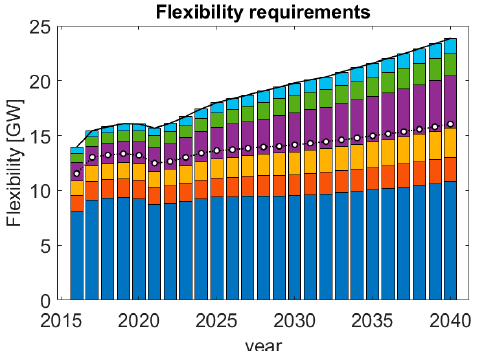
Figure 16. Current and future flexibility requirements related to MSD balancing under the TSO’s demand/VRE capacity growth scenario. Colors in the plot indicate the different Italian regions: dark blue is NORD, red is CNORD, yellow is CSUD, Purple is SUD, green is SICI and light blue is SARD.